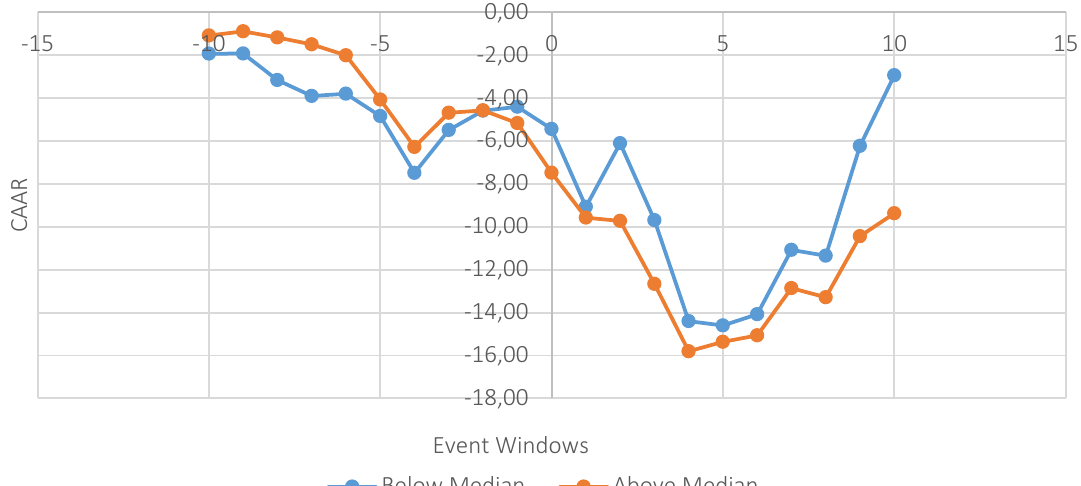
Figure 3. Day wise CAAR for both above-median and below-median market capitalization firms on the COVID-19 outbreak in different event